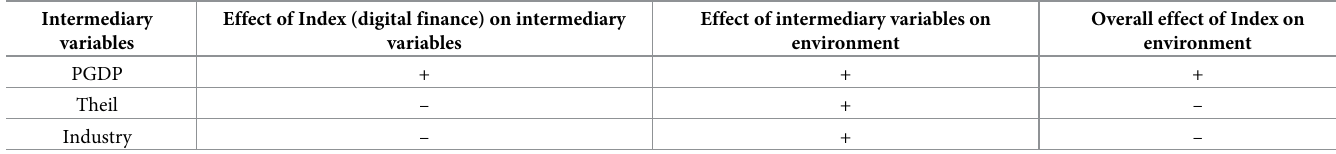
Table 5. Indirect effects of digital finance on environmental